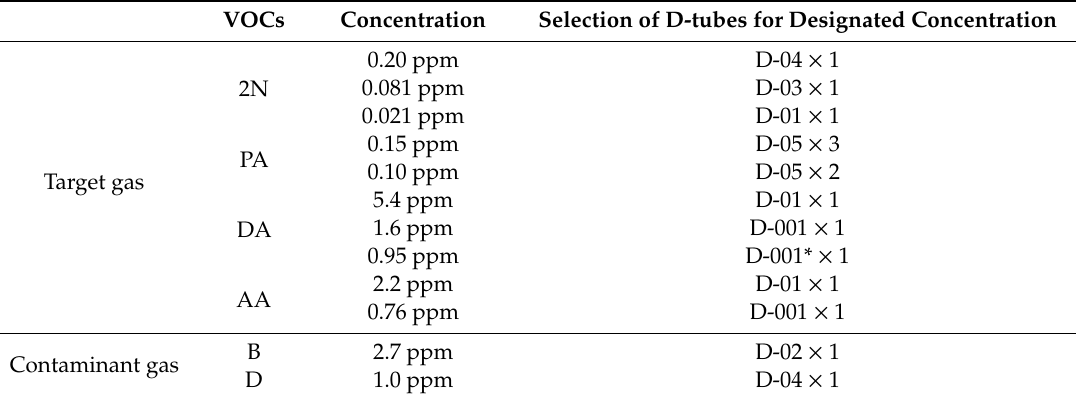
Table 2. Combinations of D-tubes employed in this study.